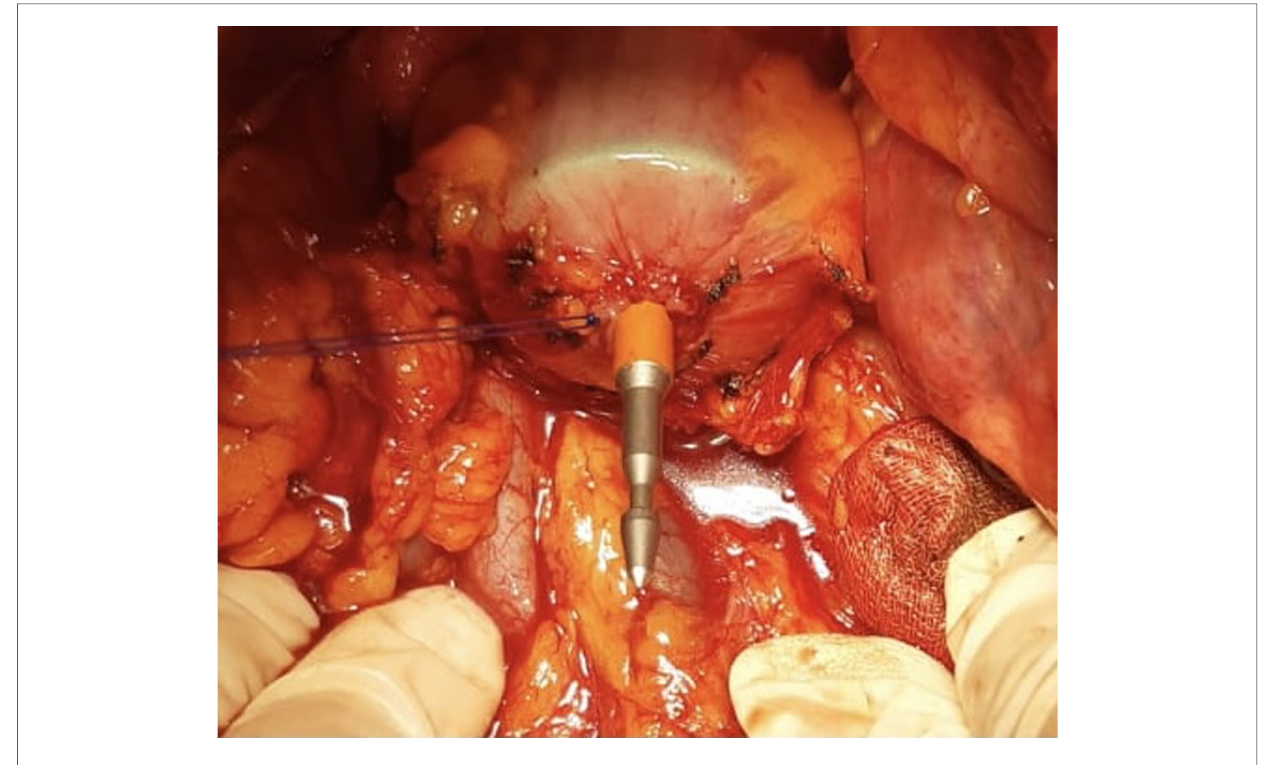
FIGURE 3 Transanal purse-string suture anastomosis.